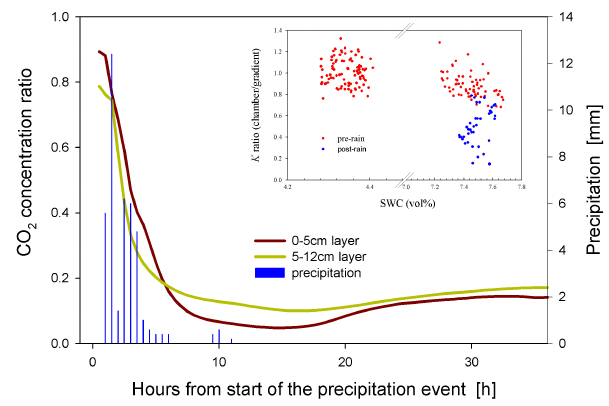
Fig. 8. Share of diffusion limitation in increase of CO 2 concen- tration in a given layer after the start of a rain event (also shown in Fig. 6) in the upper (0–5cm) and in the middle (5–12cm) soil layer. Average diurnal pre-rain CO 2 production level in the layers have been used in parallel with actual K ( as estimated by Eq. 1) val- ues. Diffusion limitation caused by the rain (decrease of air filled pore space) accounted for about 10% (middle layer), or less than 10% (upper layer) of the CO 2 concentration increase, showing pro- duction as the main driver of CO 2 concentration increase. Inset: Conductance ( K) values have been recalculated after replacing the estimated flux (Eq. 1) by chamber (Ch2) measurements. The ratio of the conductance values (from chamber/gradient fluxes, respec- tively) is shown in the function of volumetric soil water content in the upper (5cm) soil layer for two SWC ranges. The rain event causes the ratio to strongly depart from